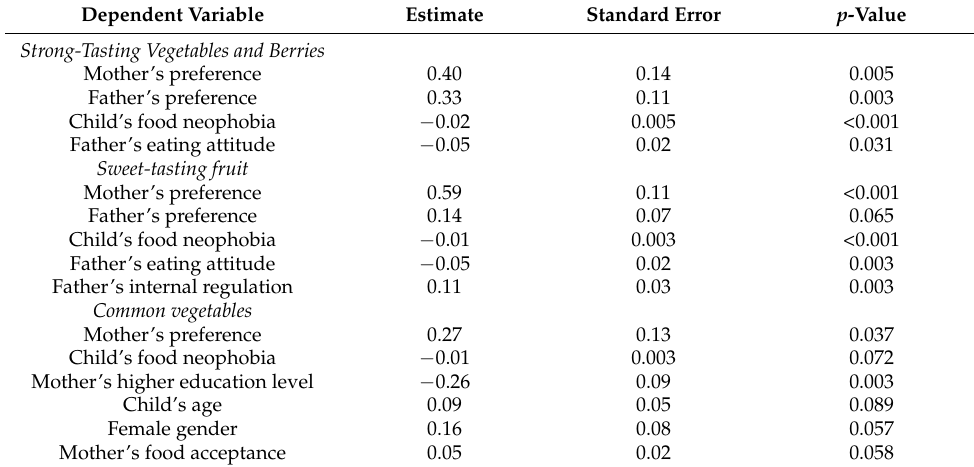
Table 4. The results of the linear mixed-effects model, fruit and vegetable preference components of 3–5-year-old children ( n = 128) as dependent